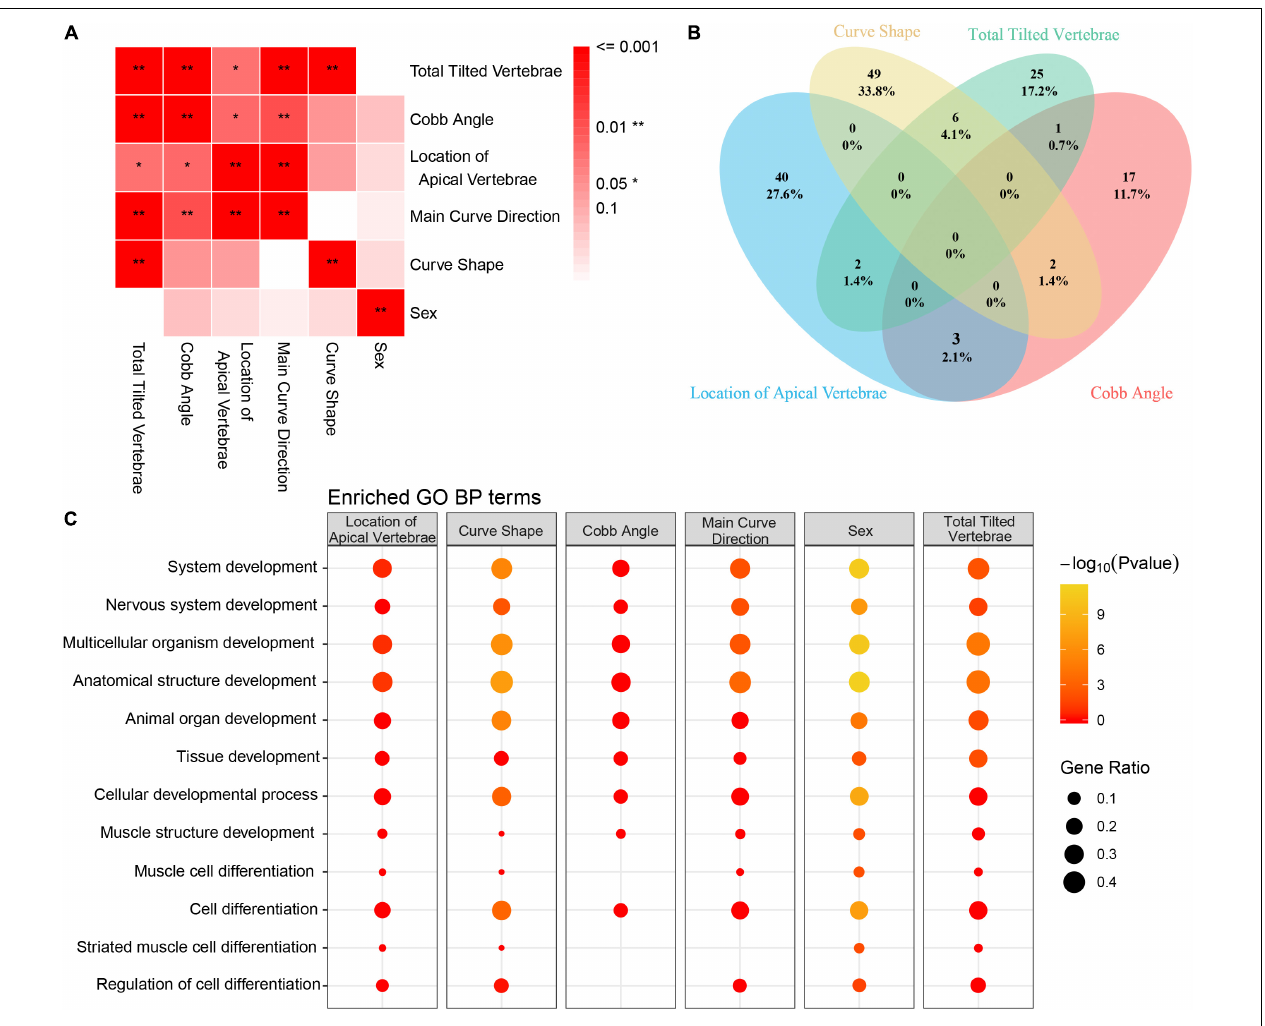
FIGURE 5 | Correlation between clinical features and Gene Ontology (GO) enrichment analysis of clinical feature-related variants. (A) The association between each clinical feature is depicted. The strength of the association is represented by the intensity of the red color. (B) Venn diagram of the distribution of each clinical feature-related variant as identified in our study (blue circle = location of apical vertebrae, yellow circle = Cobb angle, green circle = main curve direction, and pink circle = number of tilted vertebrae). (C) GO enrichment analysis of the filtered variants was performed. GO biological process (BP) annotation is indicated on the left. Each individual box represents a clinical characteristic. The –Log10 ( P -value) value is represented by color intensity, and the gene ratio is indicated by the size of the